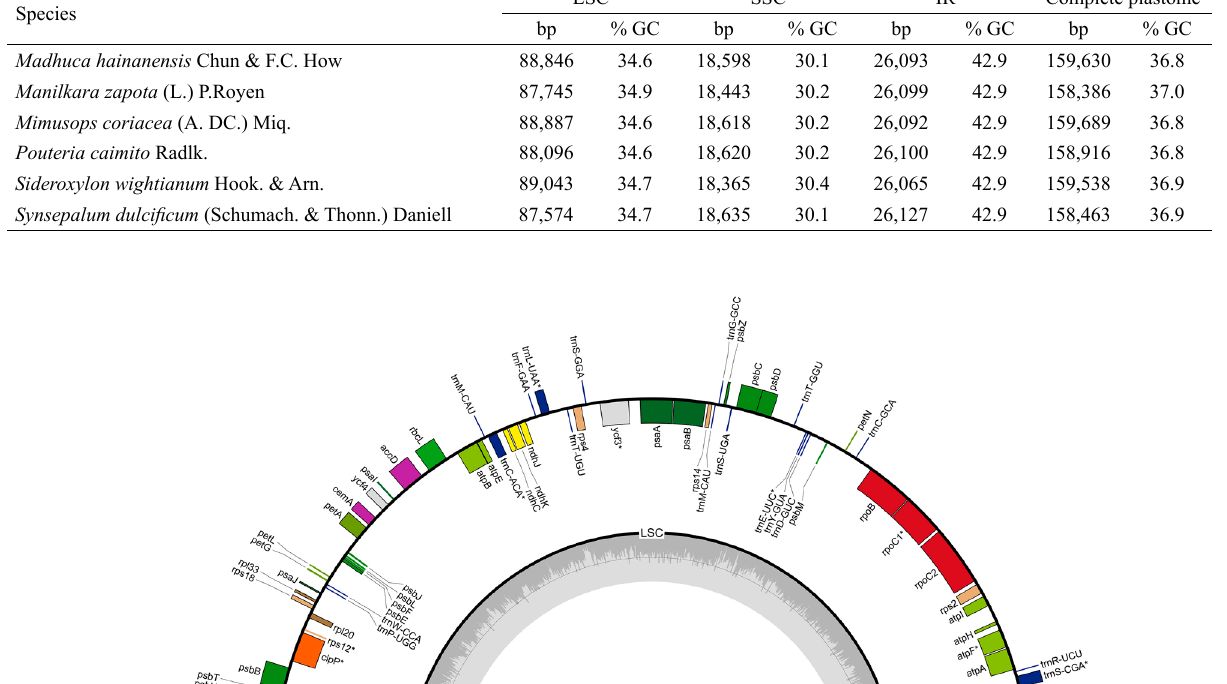
Table 1 ‒ Comparison of chloroplast genome size and GC content across three different regions (LSC, SSC, and IR) for six Sapotaceae species. LSC - large single copy; SSC - small single copy; IR - inverted repeat. Species